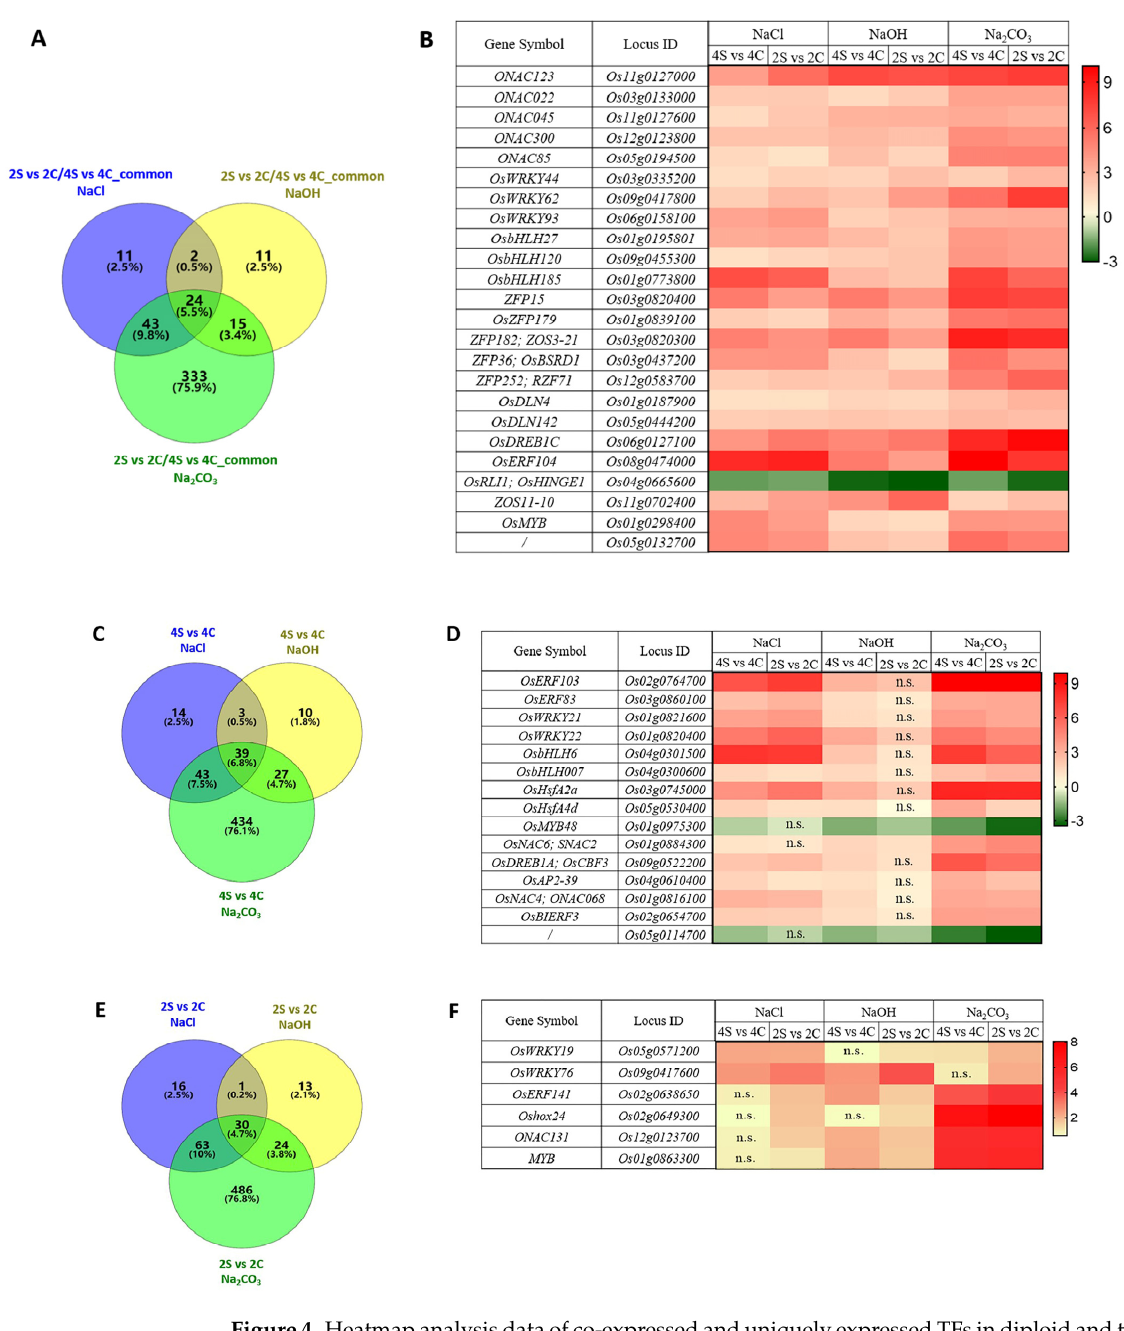
Figure 4. Heatmap analysis data of co-expressed and uniquely expressed TFs in diploid and tetraploid roots under NaCl, NaOH, and Na 2 CO 3 stress conditions. Venn diagrams of ( A ) common DE-TFs of 2S vs. 2C and 4S vs. 4C, ( C ) DE-TFs of 4S vs. 4C, and ( E ) DE-TFs of 2S vs. 2C for the three types of stress. Heat map represents ( B ) TFs co-expressed in diploid and tetraploid plants, ( D ) TFs uniquely expressed in tetraploid plants, and ( F ) TFs uniquely expressed in diploid plants. DE-TFs: differentially expressed transcription factors; n.s.: no significance. 2C and 4C represent diploid and tetraploid plants under control conditions, respectively; 2S and 4S represent diploid and tetraploid plants under three stresses,